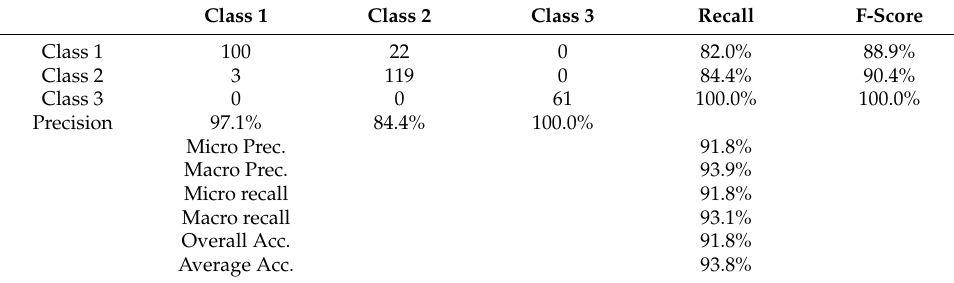
Table 3. The classification by AlexNet with 21 epoch.